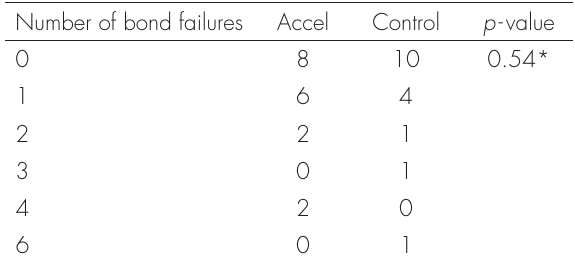
Table IV. Number of subjects sorted by the number of bond failures they experienced per